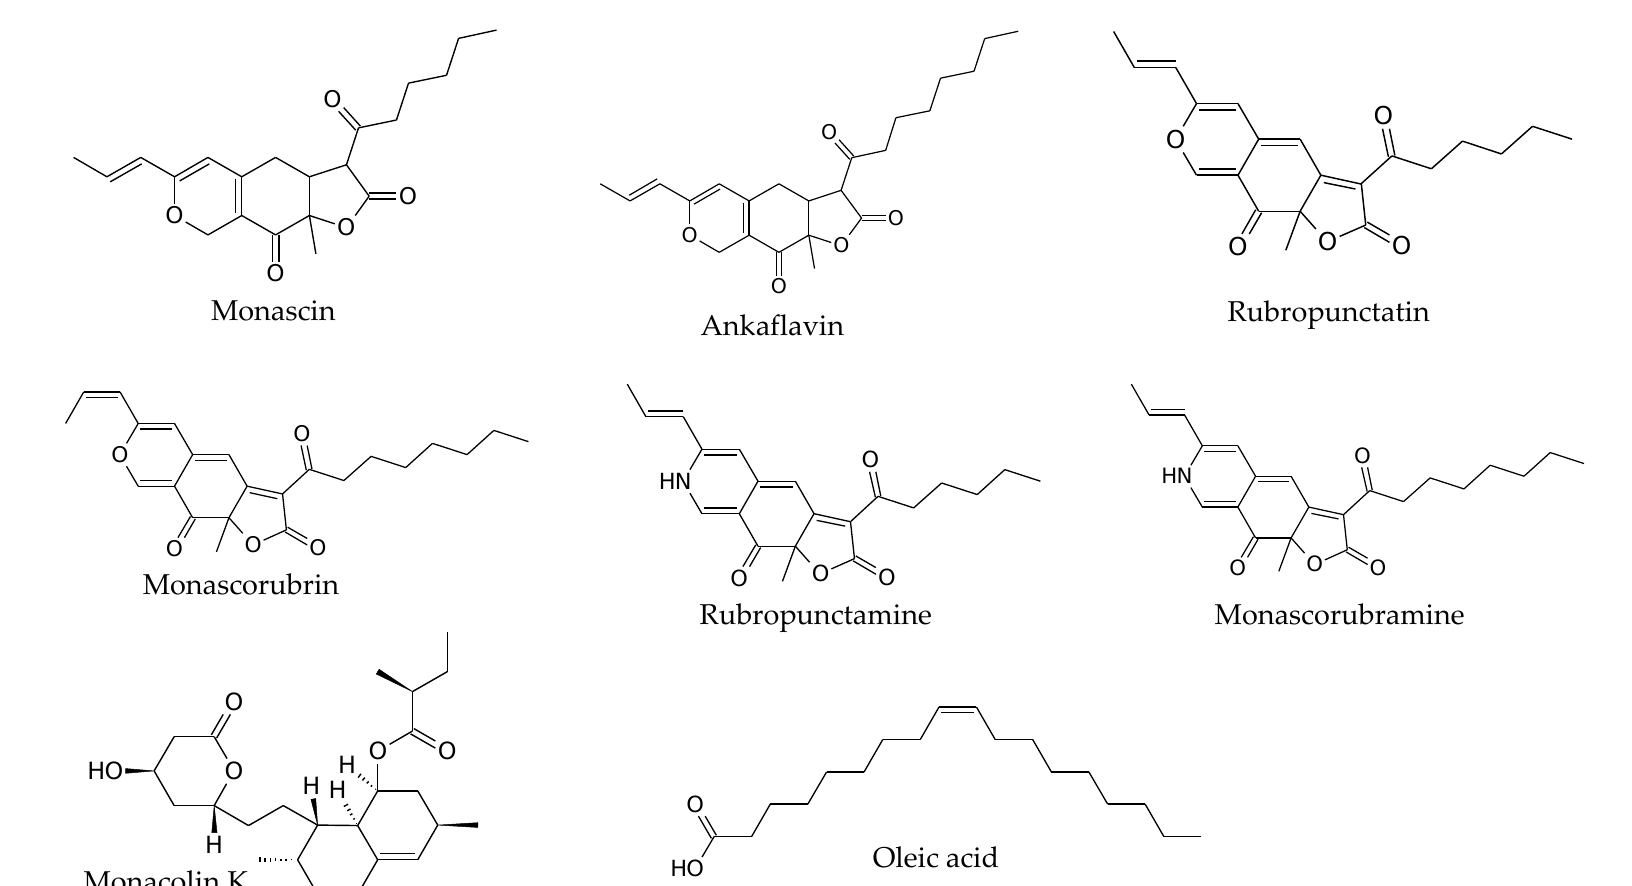
Figure 5. Structures of six main Monascus pigments, monacolin K, and oleic acid.